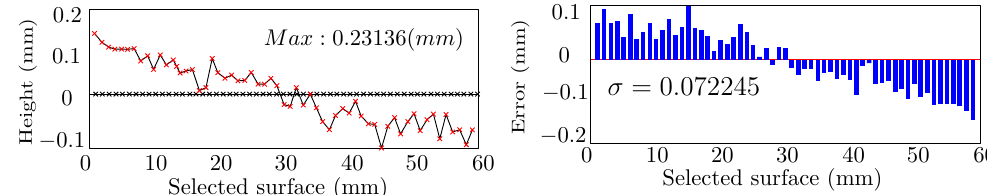
Figure 24. Evaluation of the smoothness of a milled surface by the microscanner and MATALB (2019b).